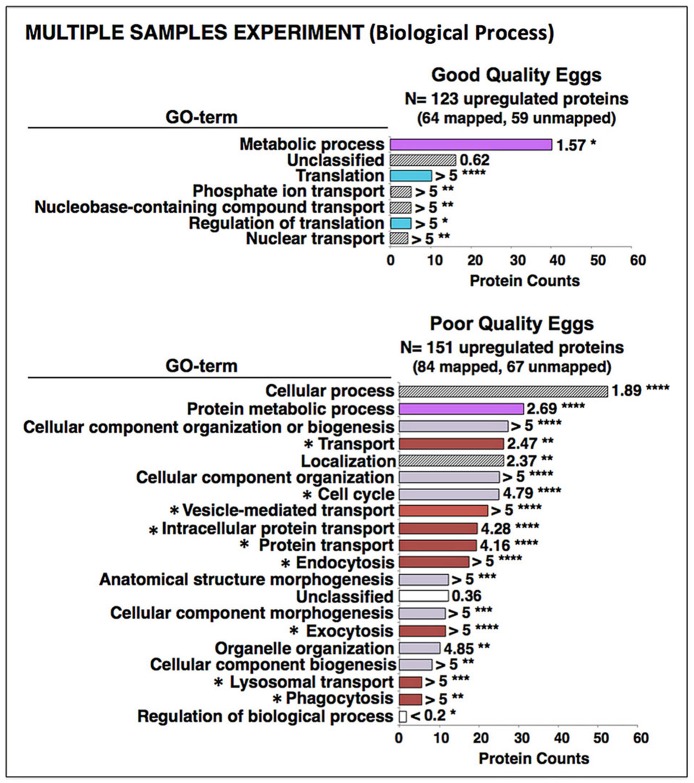
Enrichment of biological process gene ontology (GO) terms with proteins up-regulated in the Multiple Samples Experiment.Shown are the results of PANTHER over-representation tests for enrichment of Biological Process GO terms with proteins up-regulated in good and poor quality zebrafish eggs in the Multiple Samples Experiment. Top Panel. Good quality eggs. Bottom Panel. Poor quality eggs. Horizontal bars indicate the number of proteins attributed to each GO term for which statistically significant results (χ2, p<0.05) were observed. Numbers next to the bars indicate the fold-enrichment with proteins attributed to each term and the number of asterisks indicates the significance level of the enrichment, as follows p≤0.05 (*), p≤0.01 (**), p≤0.001 (***), and p≤0.0001 (****). Where possible, horizontal bars are colored to indicate corresponding protein functional categories shown in Fig 2; energy metabolism (magenta), protein synthesis (light blue), cell cycle, division, growth and fate (lavender), endosome/lysosome-related activities (brown). For poor quality eggs, GO terms preceded by an asterisk involve cytoskeletal activities. See text for details.